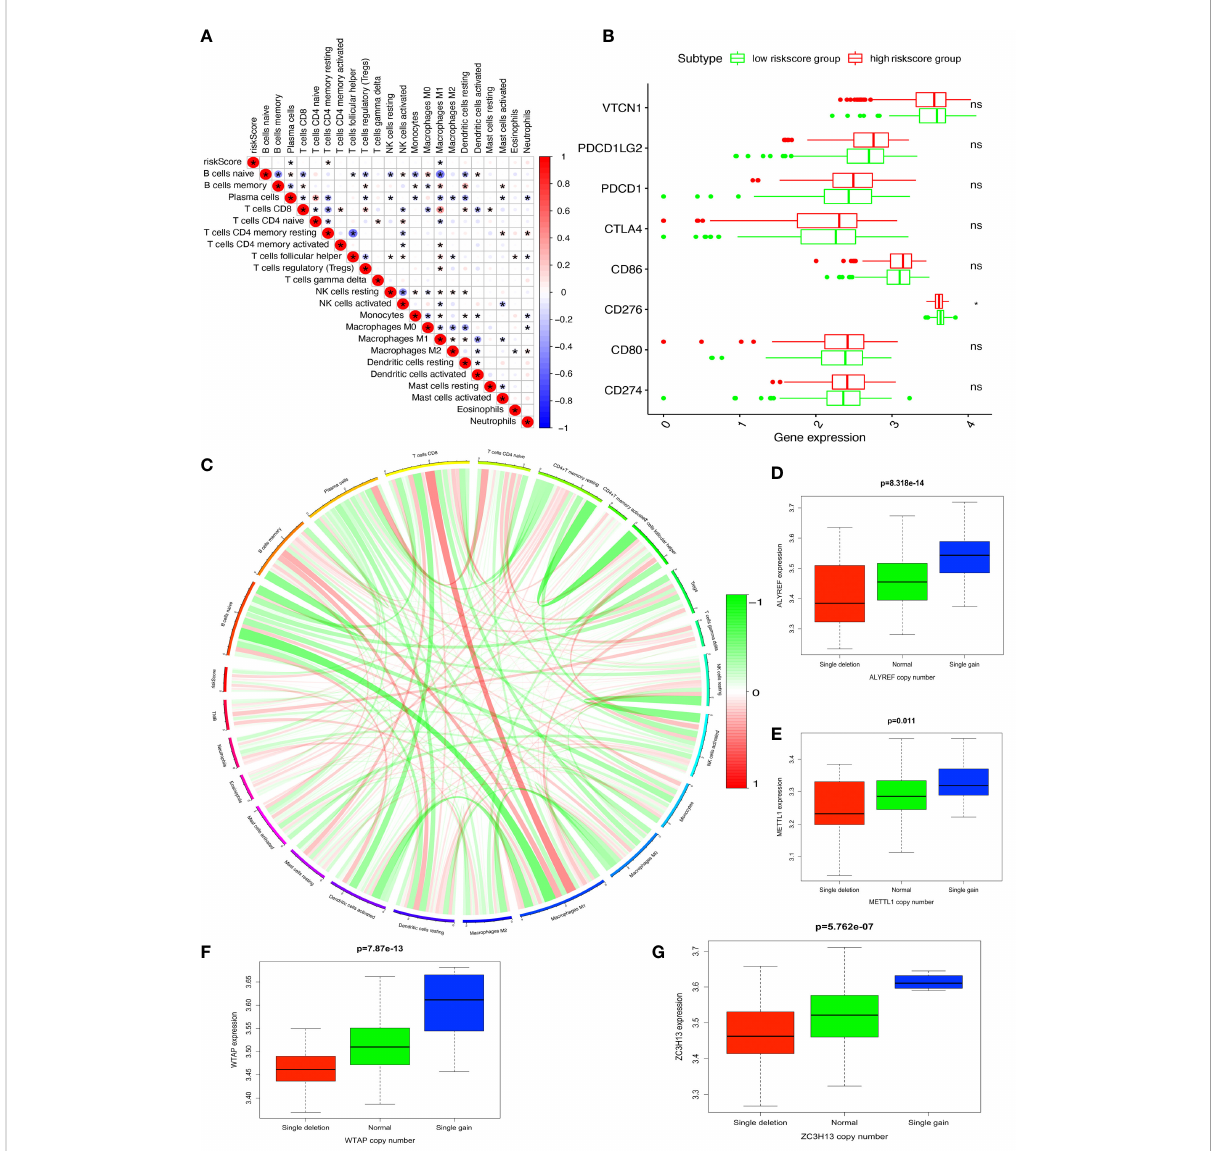
FIGURE 7 Immune and TMB between high- and low-riskscore groups. (A) The correlation between riskscore and immune cells. (B) The correlation between riskscore and immune check points. (C) The correlation between TMB and immune cells. (D) The cor-relations between mRNA expression and CNV alteration frequency of ALYREF in ovarian cancer. (E) The cor-relations between mRNA expression and CNV alteration frequency of ZC3H13 in ovarian cancer. (F) The cor-relations between mRNA expression and CNV alteration frequency of WTAP in ovarian cancer. (G) The cor-relations between mRNA expression and CNV alteration frequency of METTL1 in ovarian cancer. *p < 0.05, **p < 0.01, and ***p < 0.001. ns, no signi fi